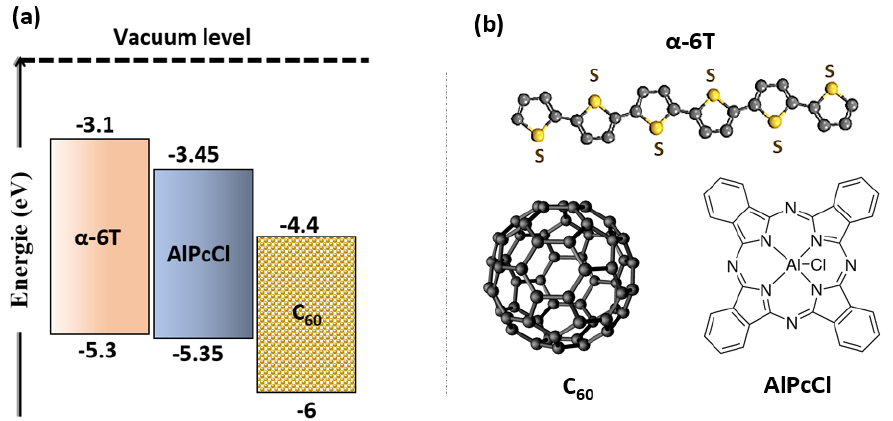
Figure 1. Energy level alignments for the different OPVs ( a ); small molecules used ( b ).